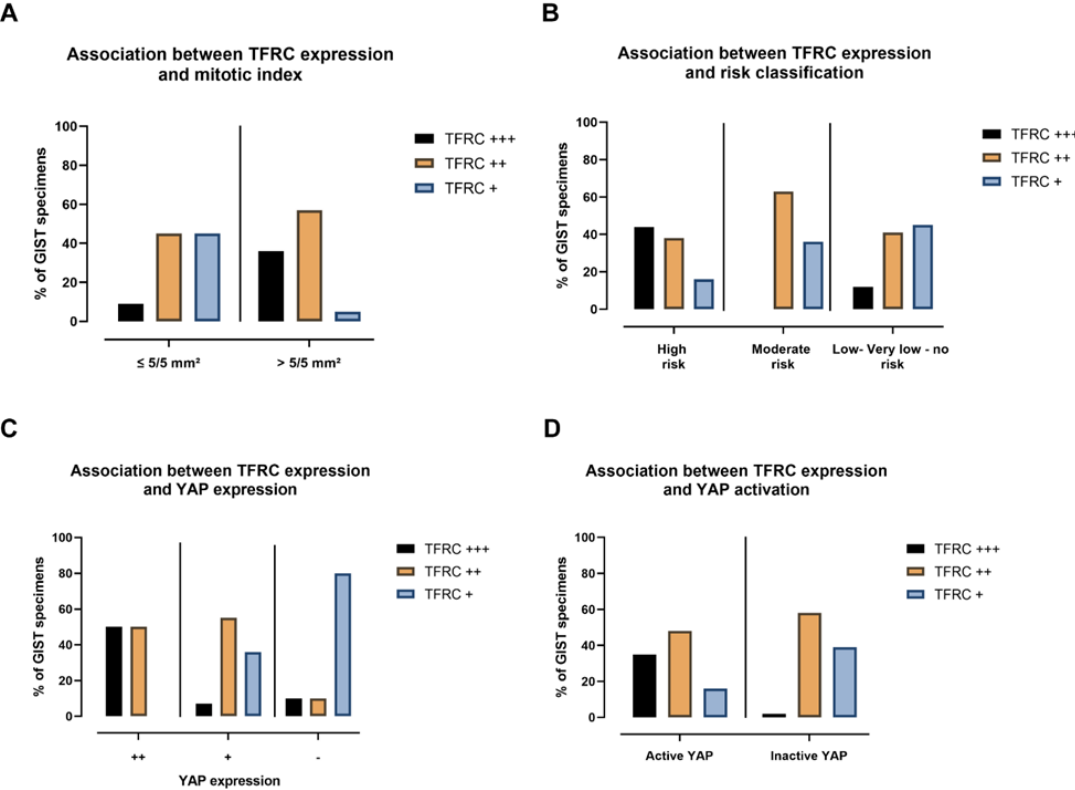
Figure 10. TFRC expression is associated with mitotic index, risk classification, YAP expression, and activation. ( A ) The percentage of TFRC-ir associated with mitotic index, ( B ) risk classification, ( C ) YAP-ir, and ( D ) YAP activation of GIST samples. Table 2. The association of TFRC-ir with YAP-ir, KIT-ir, and YAP activation in 87 GIST cases.